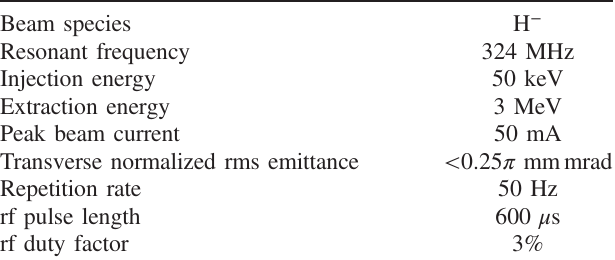
TABLE I. Requirements for J-PARC RFQ. Beam